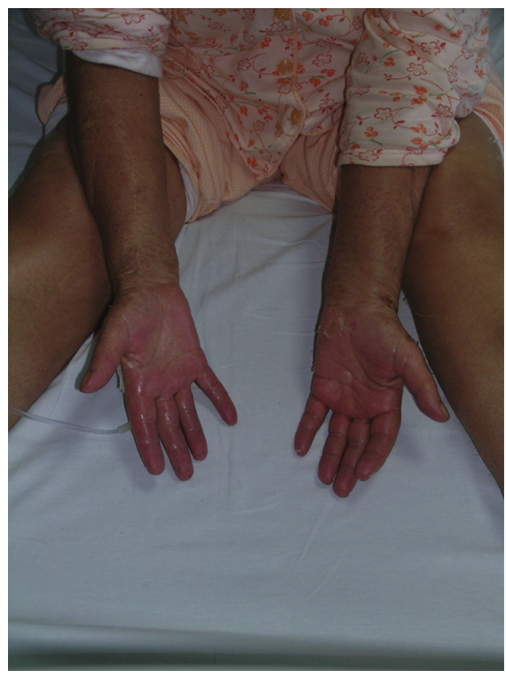
Figure 3: Erythema of the palms with generalized exfoliative